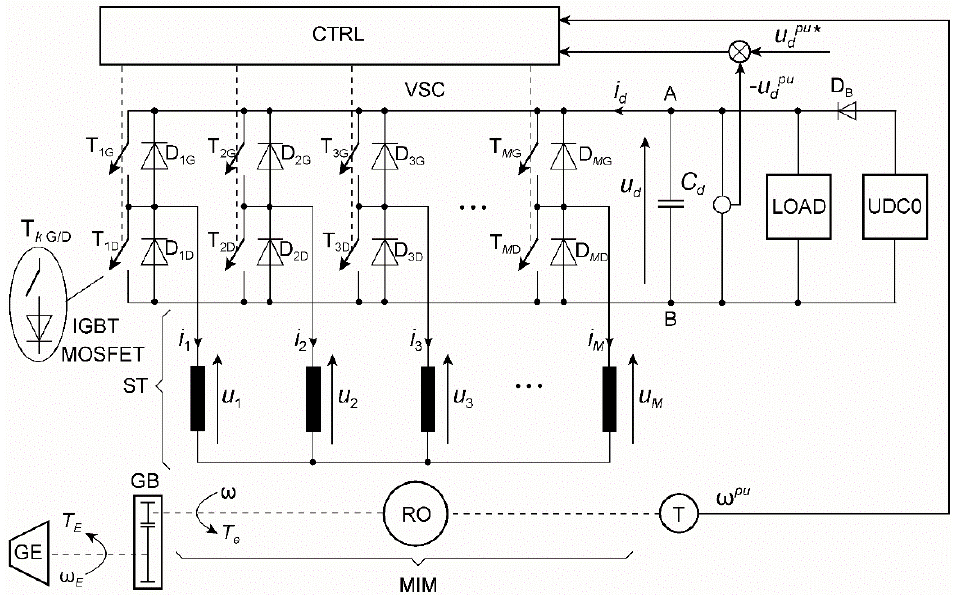
Figure 9. Circuit diagram of a VSC connected with an MIM, operating as a multiphase induction generator: GE — generator engine (e.g., a wind or water turbine), UDC0 — system assuring a mini- generator: GE—generator engine (e.g., a wind or water turbine), UDC0—system assuring a minimum mum voltage of C d , D B — blocking diode, LOAD — single resistance load (the simplest) power grid voltage of C d , D B —blocking diode, LOAD—single resistance load (the simplest) power grid supplied supplied with the grid side converter, CTRL — control system, T — speed sensor, GB — gear box (op- with the grid side converter, CTRL—control system, T—speed sensor, GB—gear box (optional), tional), ω pu — relative speed of the MIM machine related to the base reference speed Ω o . ω pu —relative speed of the MIM machine related to the base reference speed Ω o .